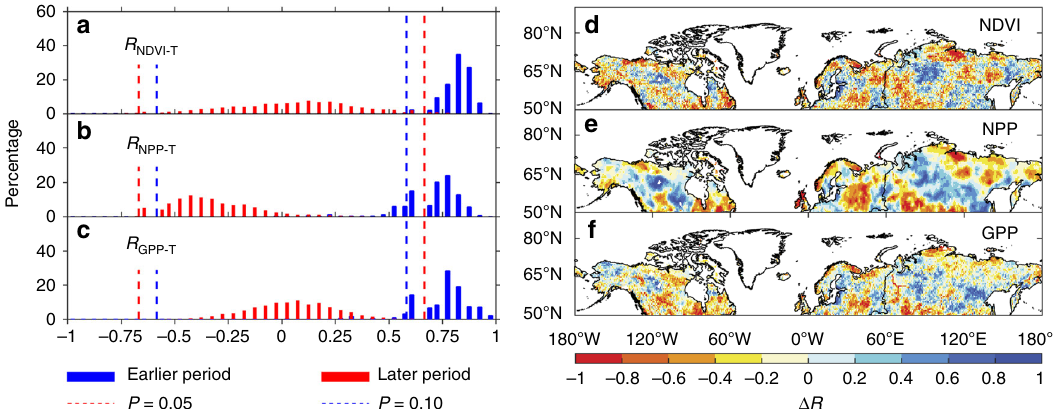
Fig. 2 Link between summer vegetation activities and summer temperature. a – c Frequency distributions of the partial-correlation coef fi cient of summer NDVI ( R NDVI-T ) ( a ), satellite-derived net primary productivity ( R NPP-T ) ( b ) and gross primary productivity based on fl ux-tower data ( R GPP-T ) ( c ) with summer temperature (T) during the earlier and later periods. Signi fi cant partial-correlation coef fi cients (based on a sample size of 11) are identi fi ed as dashed lines (magenta, P < 0.05; blue, P < 0.1). All variables were detrended for each period before the partial-correlation analysis. d – f Spatial distribution of differences of R NDVI-T , R NPP-T , and R GPP-T between the earlier and later periods. The earlier period is 1982 – 1995, and the later periods are 1996 – 2012 for NDVI, 1996 – 2011 for NPP and 1996 – 2011 for GPP. The fi gure was created using Matlab